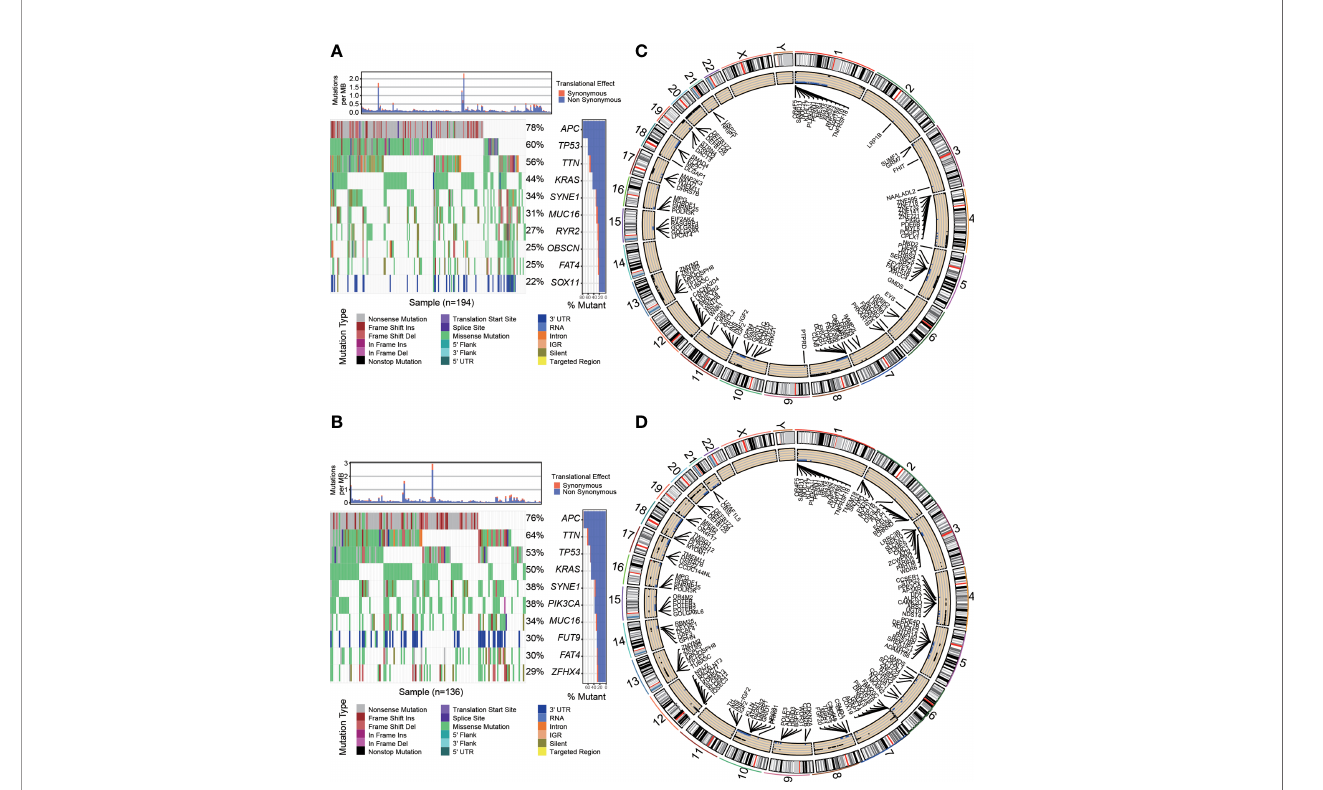
FIGURE 5 | Cancer-related somatic mutation in the two risk groups. Waterfall plots showing the SNP information in the low-risk group (A) and high-risk group (B) . The location of CNVs in the low-risk group (C) and high-risk group (D) visualized by Circos plots. The outside circle shows chromosomes; the inside circle illustrates the distribution of CNVs (black or blue points represent the copy number gain or loss,